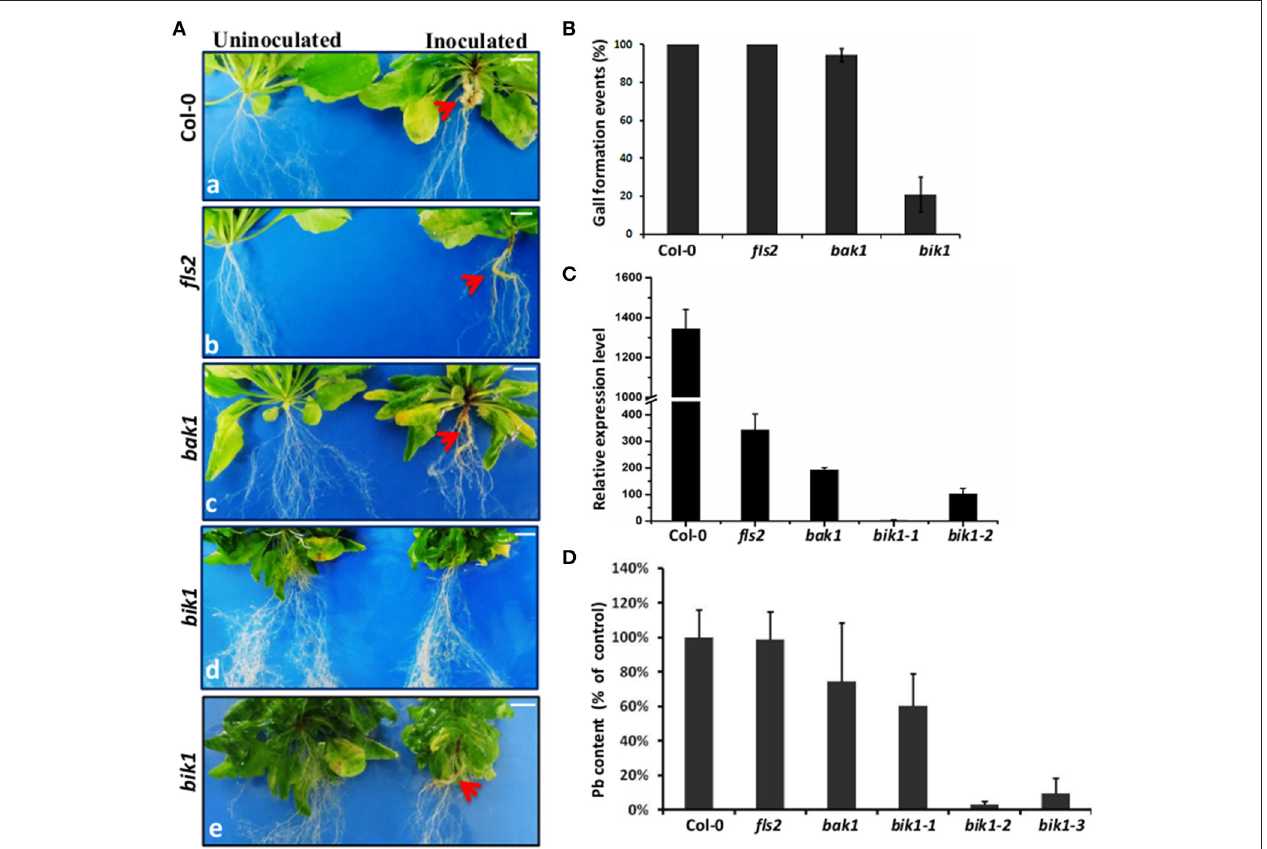
FIGURE 1 | Phenotypes and P. brassicae DNA contents in Arabidopsis control and several loss-of-function mutant roots. (A) Arabidopsis Col-0 roots (a) and several loss-of-function mutant RLKs, including FLS2 (b) , BAK1 (c) , and BIK1 (d,e) infected with P. brassicae ; the root images were captured at 21 days after P. brassicae infection. The red arrows show the galls, and bik1 showed two phenotypes: formation of small galls and no gall formation on the roots. Bar = 0.5cm. (B) Disease symptoms of Arabidopsis control roots and several loss-of-function mutants for gall comparison. Clubroot symptoms were quantified for three biological replicates, each containing 30 plants per genotype. However, for some mutants especially the bik1 mutants several plants were excluded before statistics due to a poor growth (with very small shoots and roots). The error bars represent the SD of the experimental values obtained from three biological replicates. (C) Real-time PCR analysis was performed to assess the expression levels of P. brassicae at 21 days after inoculation . bik1-1 showed no root gall formation, and bik1-2 showed root gall formation. Root sample is a mixture of roots from different plants of the same mutant (over 3 plants). The error bars represent the SD of the experimental values obtained from three technical replicates. (D) Pathogen DNA quantification (Pb) by quantitative PCR, expressed the percentage of the mean Pb content in inoculated roots of Col-0, fls2, bak1, and bik1 at 21 days after inoculation with P. brassicae. At least 3 plant roots were taken as mixed sample. bik1-1 showed